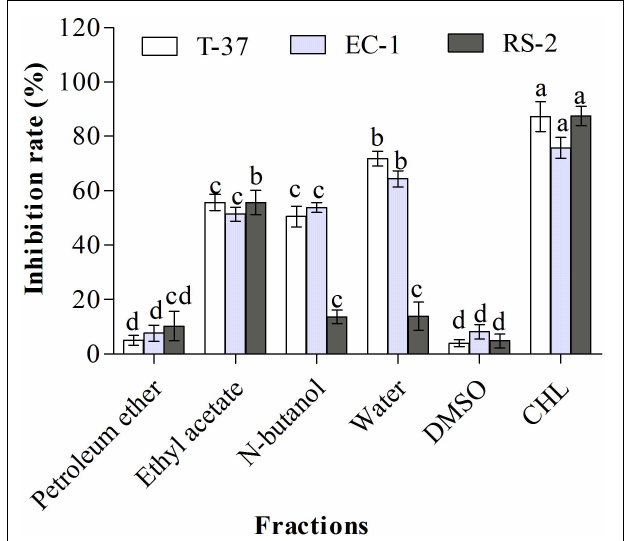
FIGURE 1 | Antibacterial activities of organic extract fractions against the test bacteria. T-37, EC-1, and RS-2 represent Agrobacterium tumefaciens T-37, Erwinia carotovora EC-1, and Ralstonia solanacearum RS-2, respectively. DMSO represents dimethyl sulfoxide. CHL represents chloramphenicol. Different lowercase letters indicate significant differences ( P <